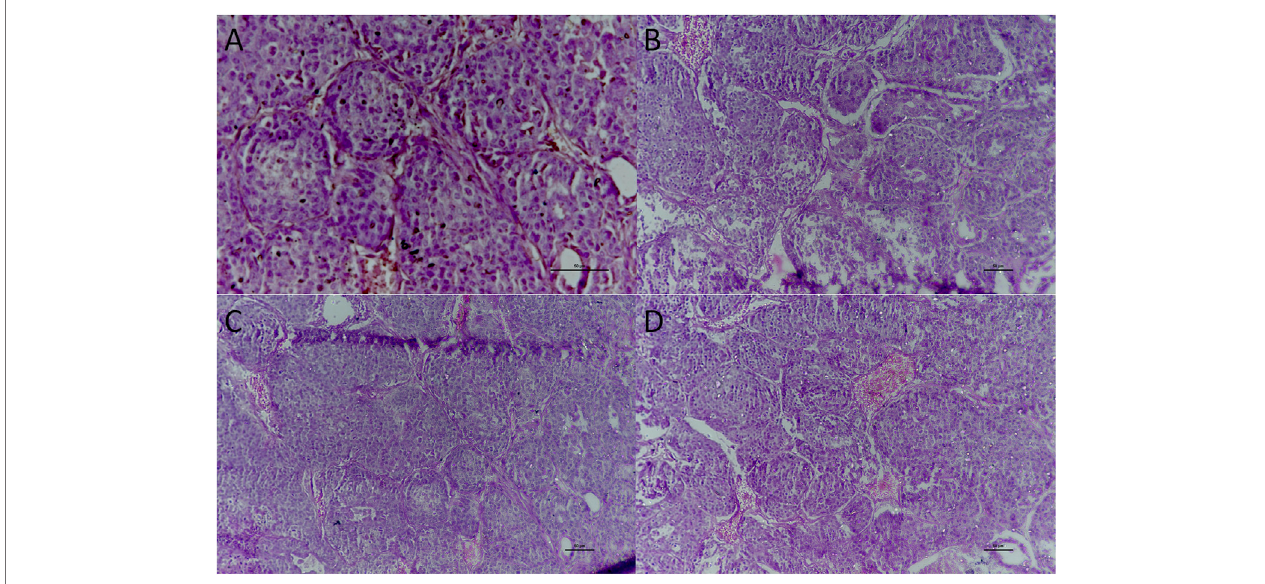
FIGURE 7 | Histological examination of the mammary gland tissue of studied groups. (A) Group A x400 treated as control; (B) Group B x200 treated with DMBA; (C) Group C x200 treated with 4-(methylthio)butyl isothiocyanate; (D) Group D x200 treated with DMBA and then 4-(methylthio)butyl isothiocyanate.